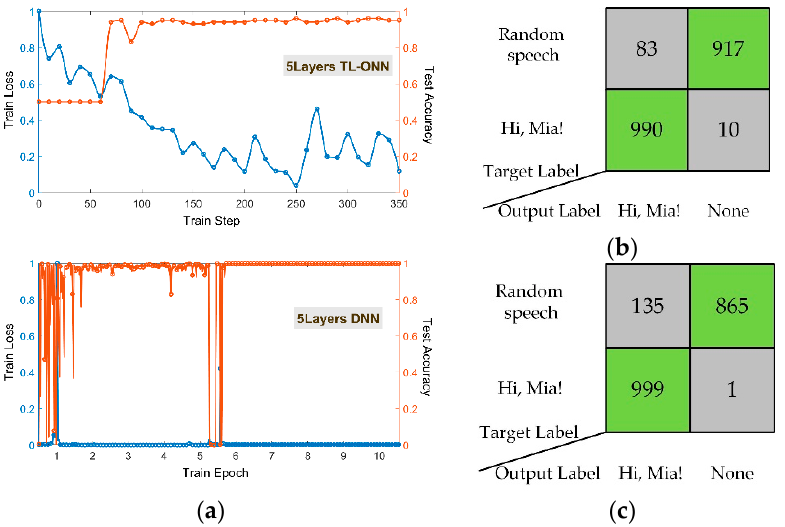
Figure 3. ( a ) Change curves of the loss function and accuracy of training TL-ONN (top) and deep neural network (DNN) (bottom) with 18,000 sets of speech data each. ( b , c ) Statistical results of the number of correct (green squares) and incorrect (grey squares) output label after the training of the two networks’ architecture is completed. We define the accuracy rate as the percentage of the correct result in the total test set data (2000).